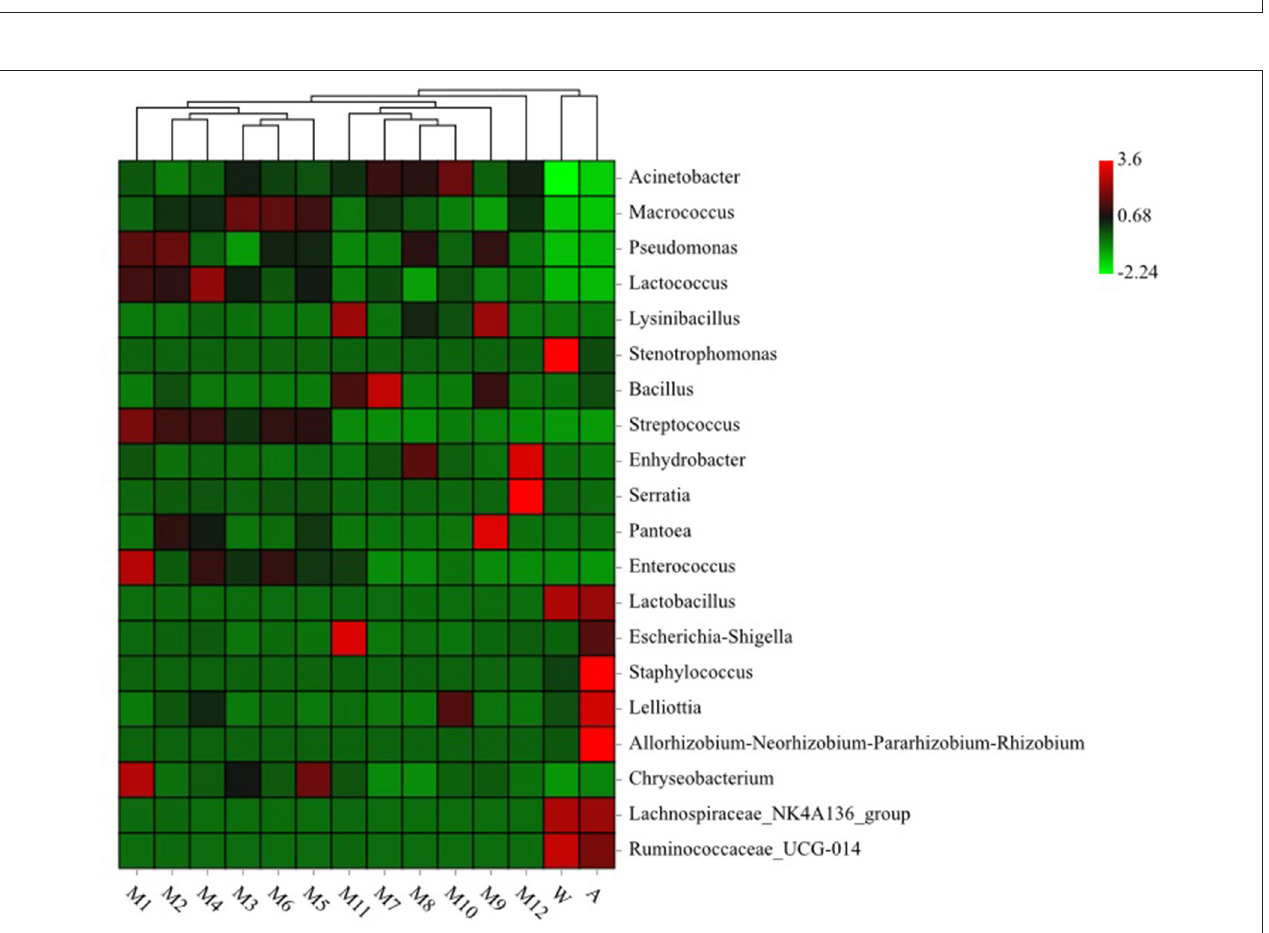
Frontiers in Nutrition |